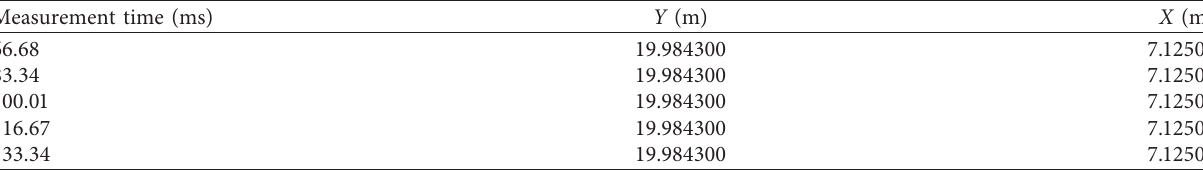
Table 3: Panoramic segmentation accuracy.